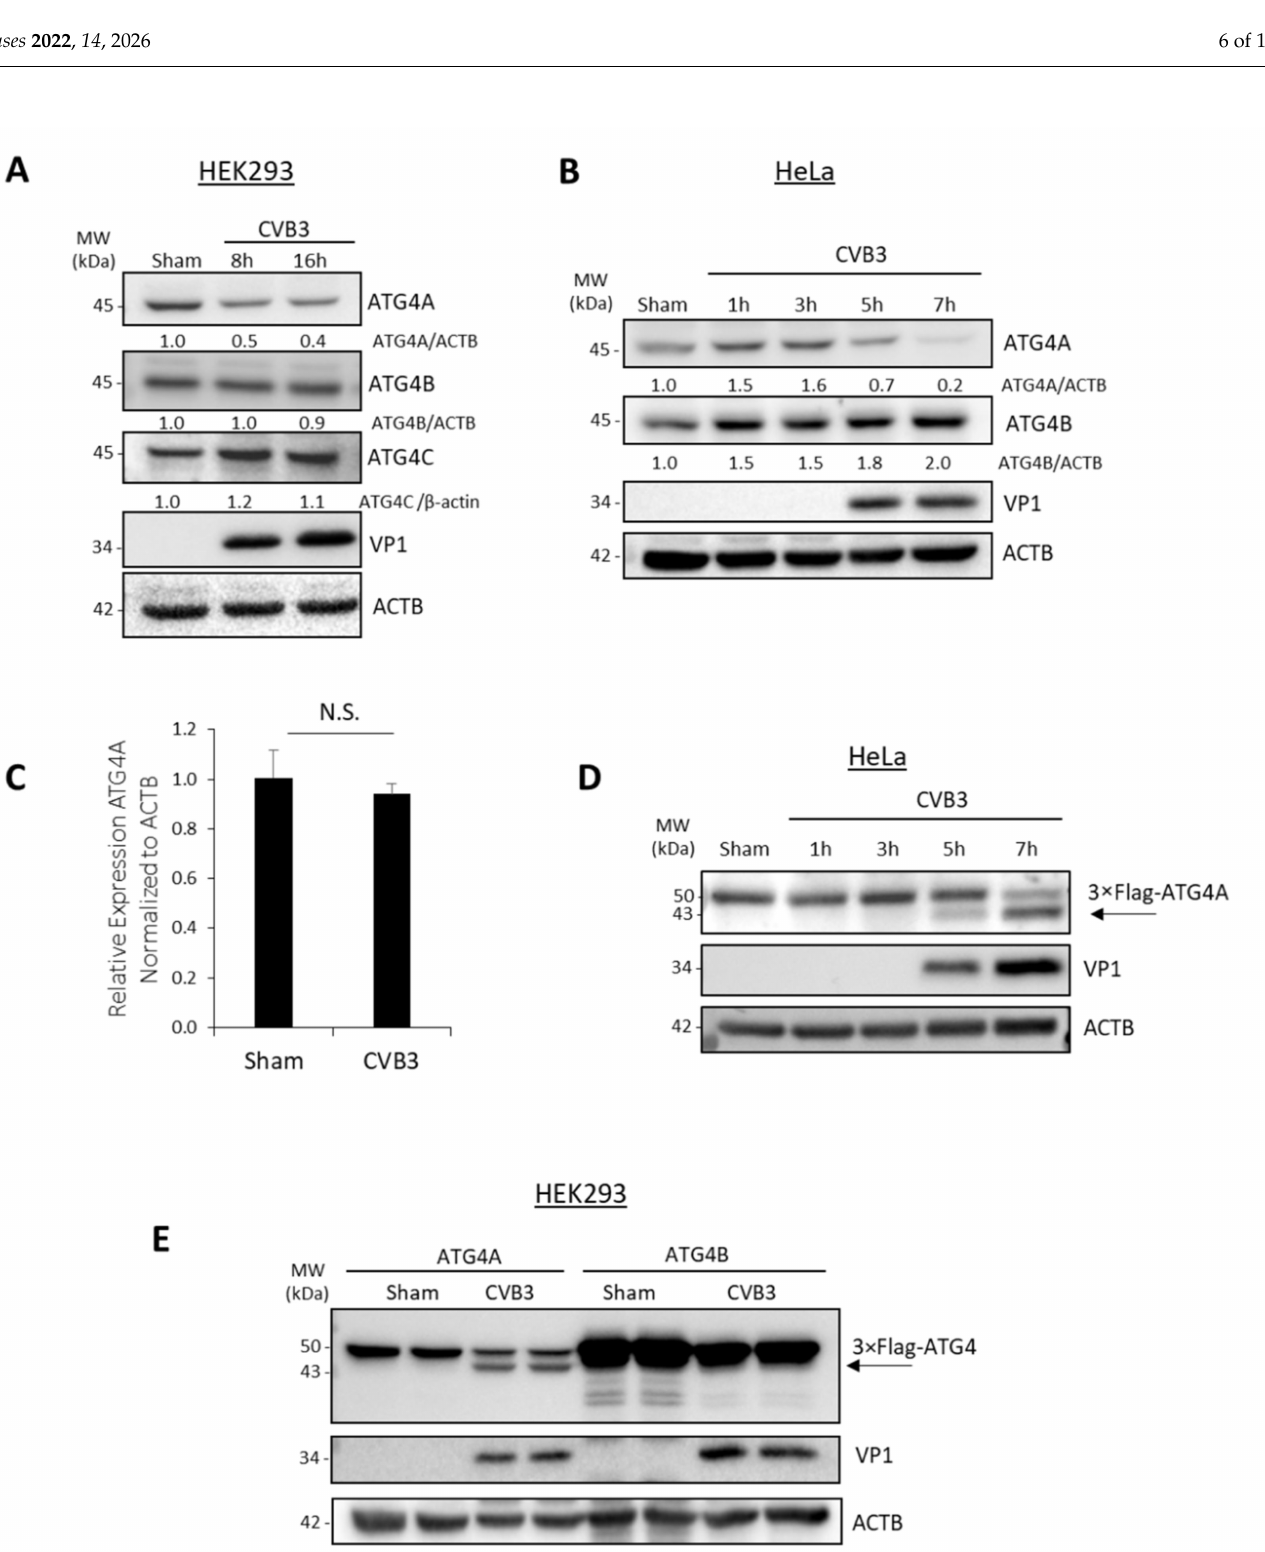
Figure 1. ATG4A is cleaved following CVB3 infection. ( A , B ) HEK293T ( A ) and HeLa ( B ) cells were infected with CVB3 at an MOI of 100 and 10, respectively, for various time as indicated or sham-infected with DMEM. Cell lysates were harvested for Western blot analysis of ATG4A, ATG4B, ATG4C. Viral capsid protein VP1 and housekeeping protein ACTB were probed and served as viral infection and loading control, respectively. Densitometric analysis of ATG4A, ATG4B, and ATG4C protein levels was performed using NIH Image J, normalized to ACTB and presented underneath each band as fold changes where sham groups were arbitrarily set to 1.0. ( C ) Sham and